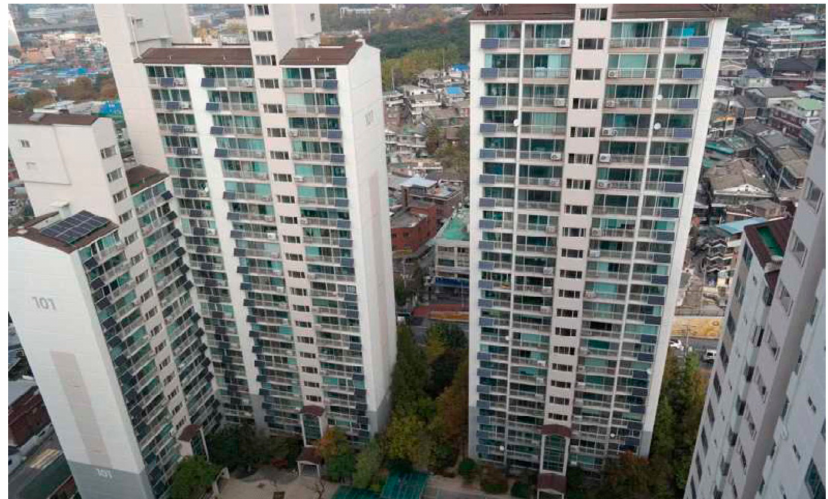
Figure 2. Installed mini-PV in Hongreung Dongbu Apartment